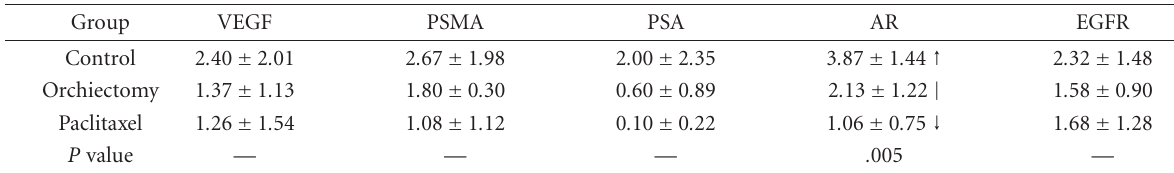
Table 1. Immunohistochemical staining.